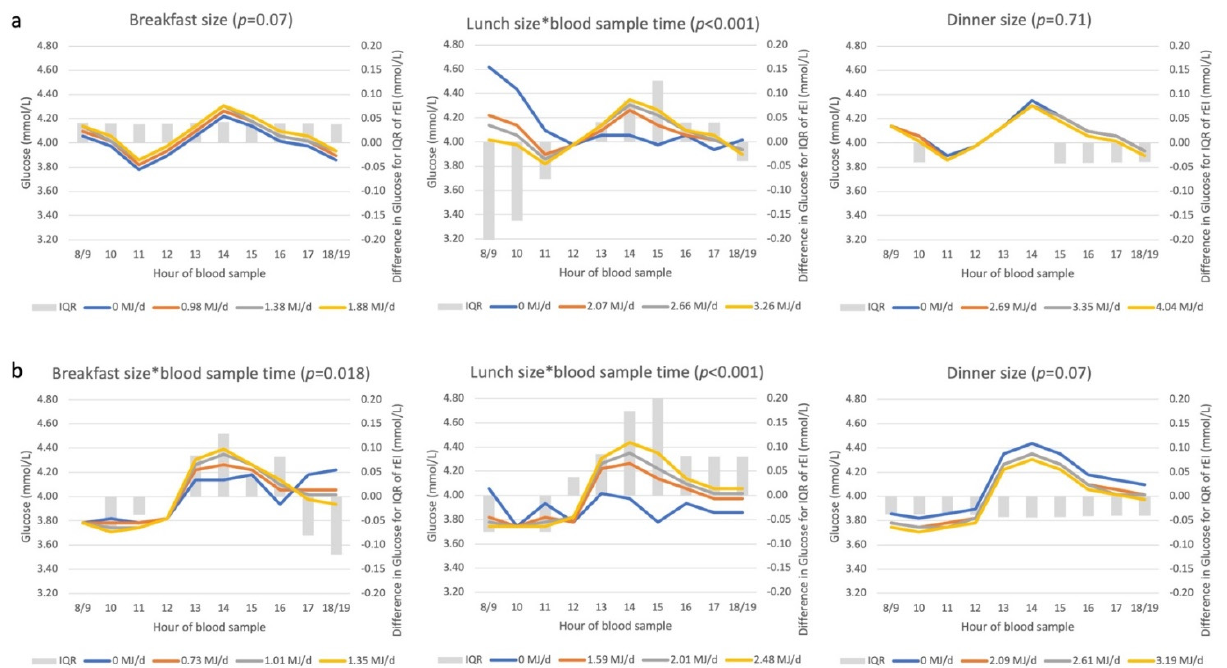
Figure 5. Associations between rEI at three recording sections (‘meal size’) and glucose concentrations among men ( a ) and women ( b ). Abbreviations: DEI, daily energy intake (MJ/d); IQR, interquartile range; rEI, reported energy intake. The p -value represents the statistical significance of the interaction term between rEI and time (*), as assessed with the F-test. Where the interaction term was non-significant, the p -value is the statistical significance of the recording section size, as assessed with the F-test. See Appendix D for description of axes, model and interpretation of the graph.